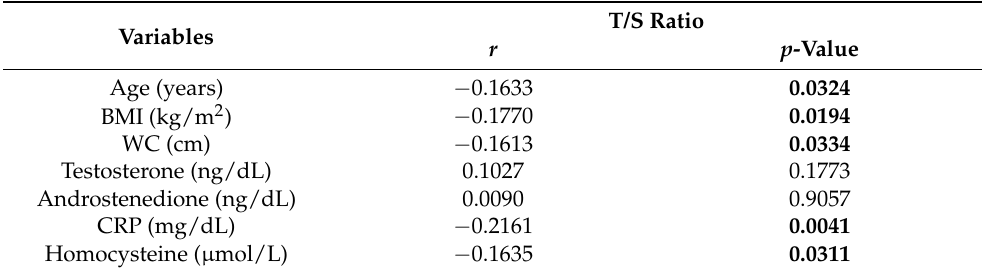
Table 2. Pearson correlation analysis between telomere length and quantitative variables in PCOS women, regardless of